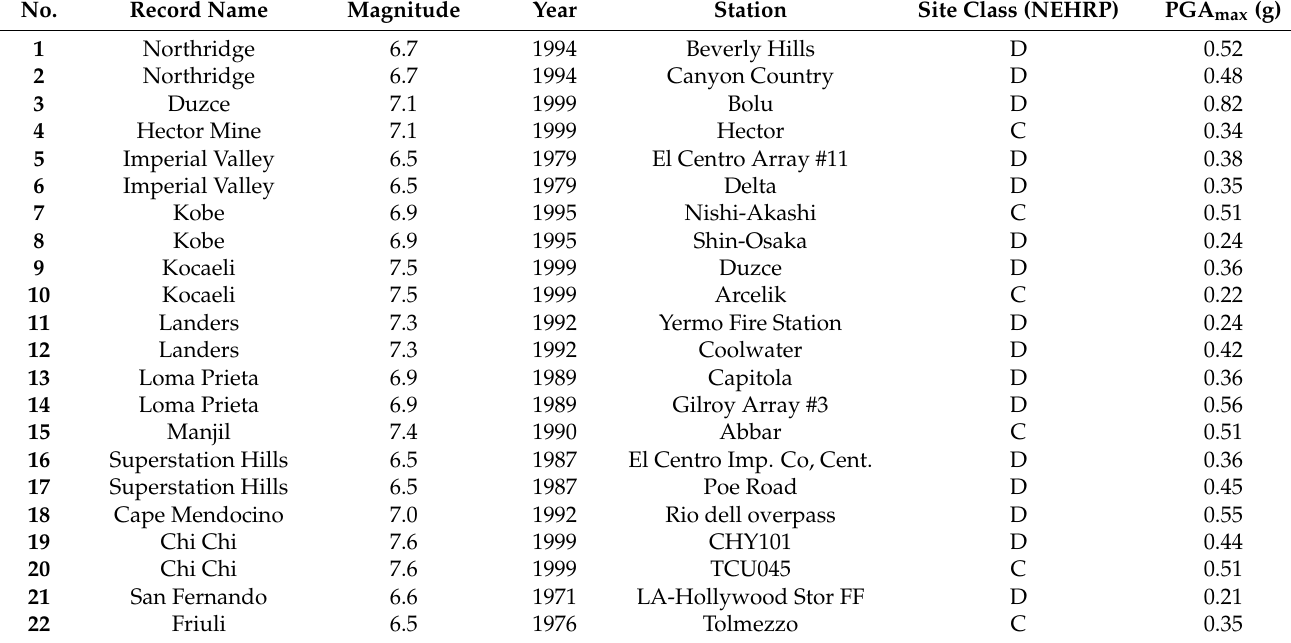
Table 5. Properties of the far-field record set used in